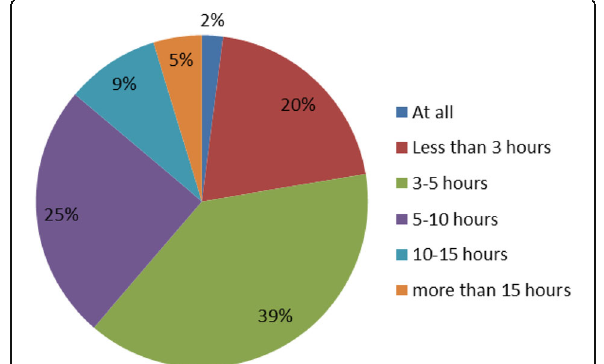
Fig. 13 Average time within the week period dedicated to physical activity in the analysed group of